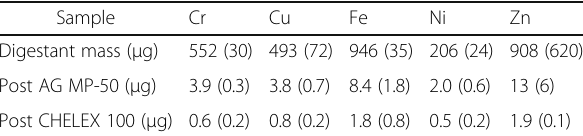
Table 3 The average mass ( n = 3, 1 σ ) of contaminant metals measured in the digestant and the eluate recovered from the AG MP-50 and CHELEX 100 resin